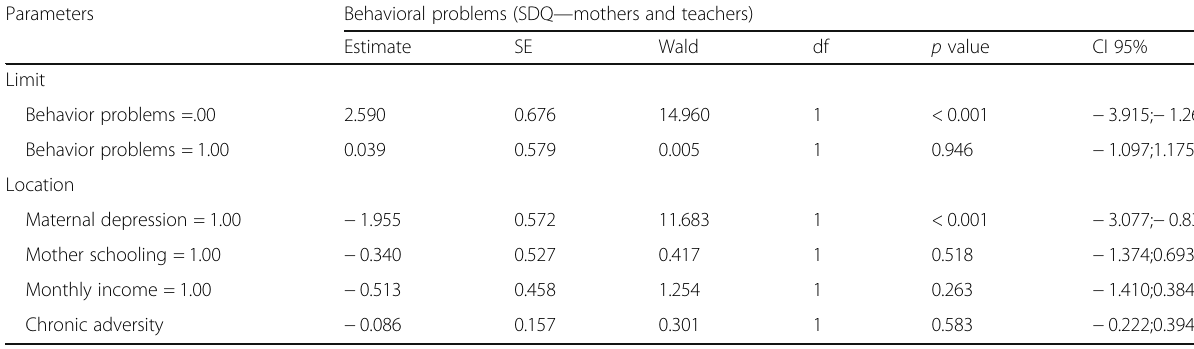
Table 3 Multiple ordinal regression with contextual variables for behavioral problems ( n = 85) Parameters Behavioral problems (SDQ — mothers and teachers)